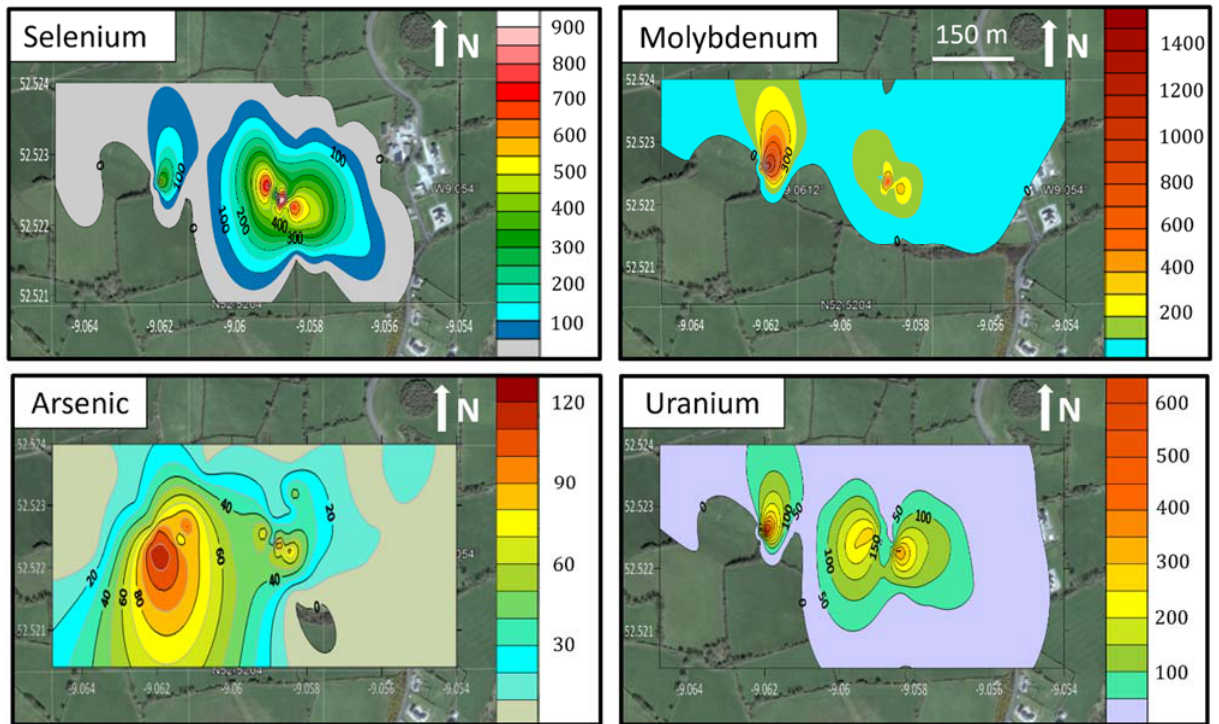
Figure 3. Maps showing the spatial distribution of selenium, molybdenum, arsenic and uranium concentrations in soils at 10–20 cm at site FF, produced using Golden LLC Surfer ® V15 software and superimposed on a Google Earth image of Ballyegny Beg, West Limerick (52°31 ′ 22 ′′ N; 9°3 ′ 32 ′′ W) (Google Earth Pro, ©Google. Image© Maxar Technologies, using Kriging griding). Values in ppm, axes longitude/latitude.